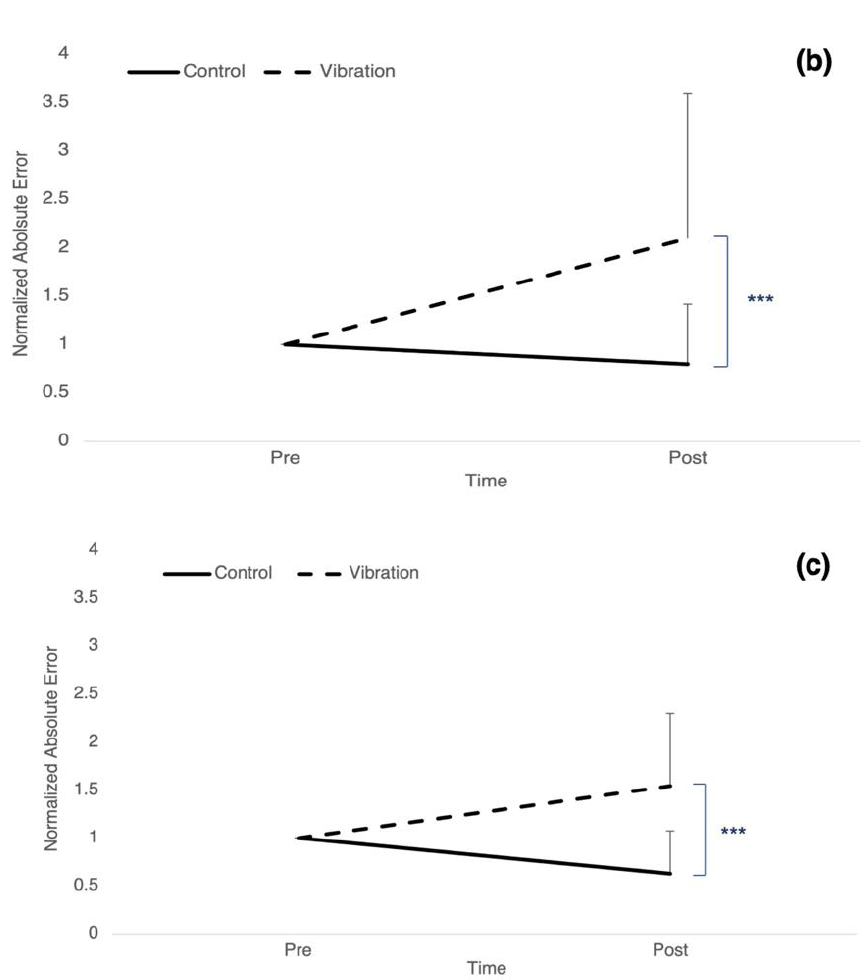
Figure 2. Normalized mean absolute error for controls (solid line) and vibration group (dashed line). Post measures have been normalized to baseline scores. ( a ) target angle 1 between 80–90 degrees. ( b ) target angle 2 between 90–100 degrees. ( c ) target angle 3 between 100–110 degrees. Error bars represent SD. (*** p ≤ 0.001).